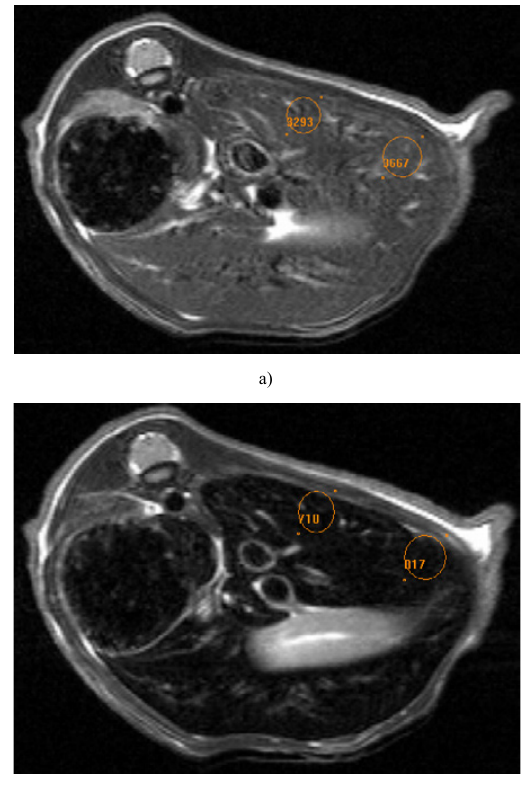
Fig. 8. MR image of a mouse a) before injection and b) 30 minutes after IV injection of sample A1. Signal intensity decrease is evident in the elliptical shown regions of